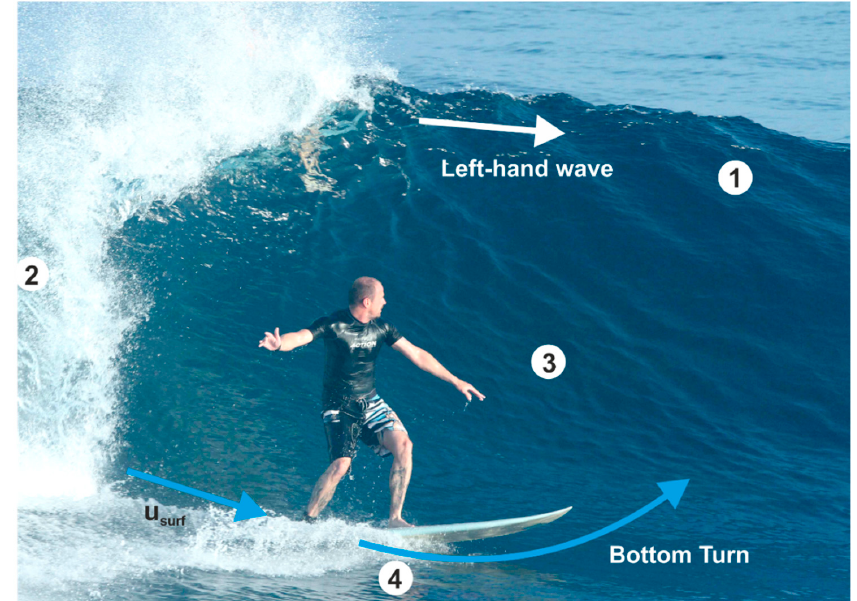
Figure 2. M. Döllinger surfs a bottom turn in a left-hand wave at Uluwatu (Bali). (1) The Lip: the top of the wave. (2) The Falling Lip: the wave zone is thrown forward as the wave breaks. (3) The Pocket: the optimal energy zone for getting the maximum surfing velocity. (4) The Flat Zone: the zone in front of the broken wave, which will slow down the surfing velocity.